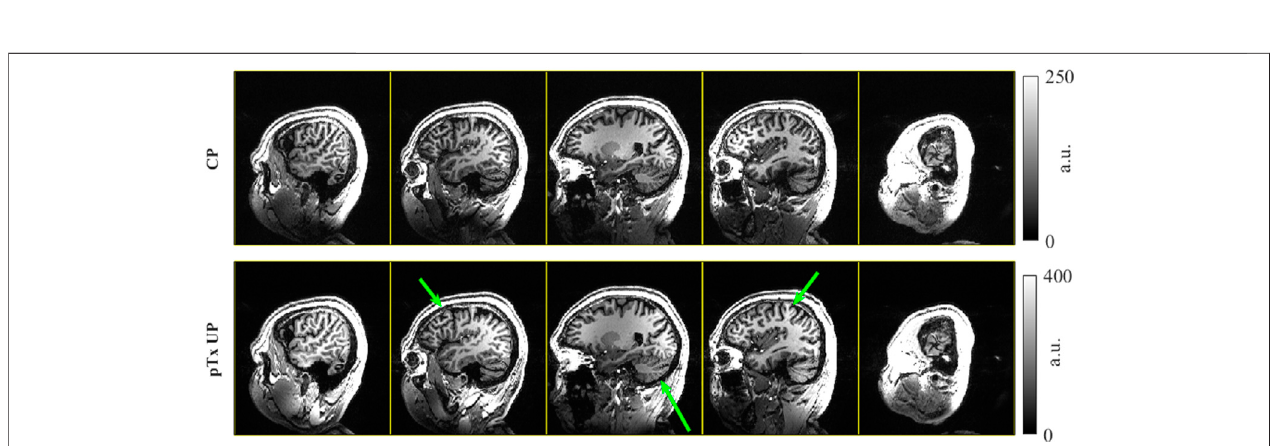
FIGURE 13 | T1w MPRAGE images collected in a healthy volunteer with the self-built coil in pTx mode. The top row shows the images acquired in CP mode, equivalent to the sTx case. The bottom row shows the images using dynamic pTx with Universal Pulses for excitation. Both images used the same CP mode 350 V adiabatic inversion and are windowed to have the same contrast. The green arrows highlight a few regions where the UP excitation improves the B 1+ homogeneity and resulting image uniformity.